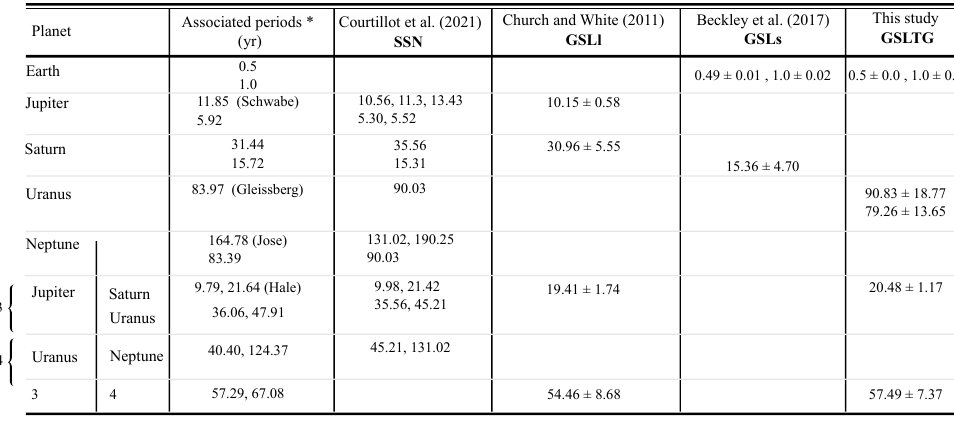
Figure 5. The first six most important components extracted from GSLTG . ( a ) First SSA component (1 yr) of the GSLTG data series of Figure 4b. ( b ) Second SSA component ( ∼ 90 yr) of the GSLTG data series. ( c ) Third SSA component ( ∼ 60 yr) of the GSLTG data series. ( d ) Fourth SSA component ( ∼ 80 yr) of the GSLTG data series. ( e ) Fifth SSA component (0.5 yr) of the GSLTG data series. ( f ) Sixth SSA component ( ∼ 20 yr) of the GSLTG data series. Table 2. Commensurate periods of the Jovian planets [41,51]. Periods of components extracted by SSA from sunspot series SSN , GSLl , GSLs and GSLTG are highlighted in